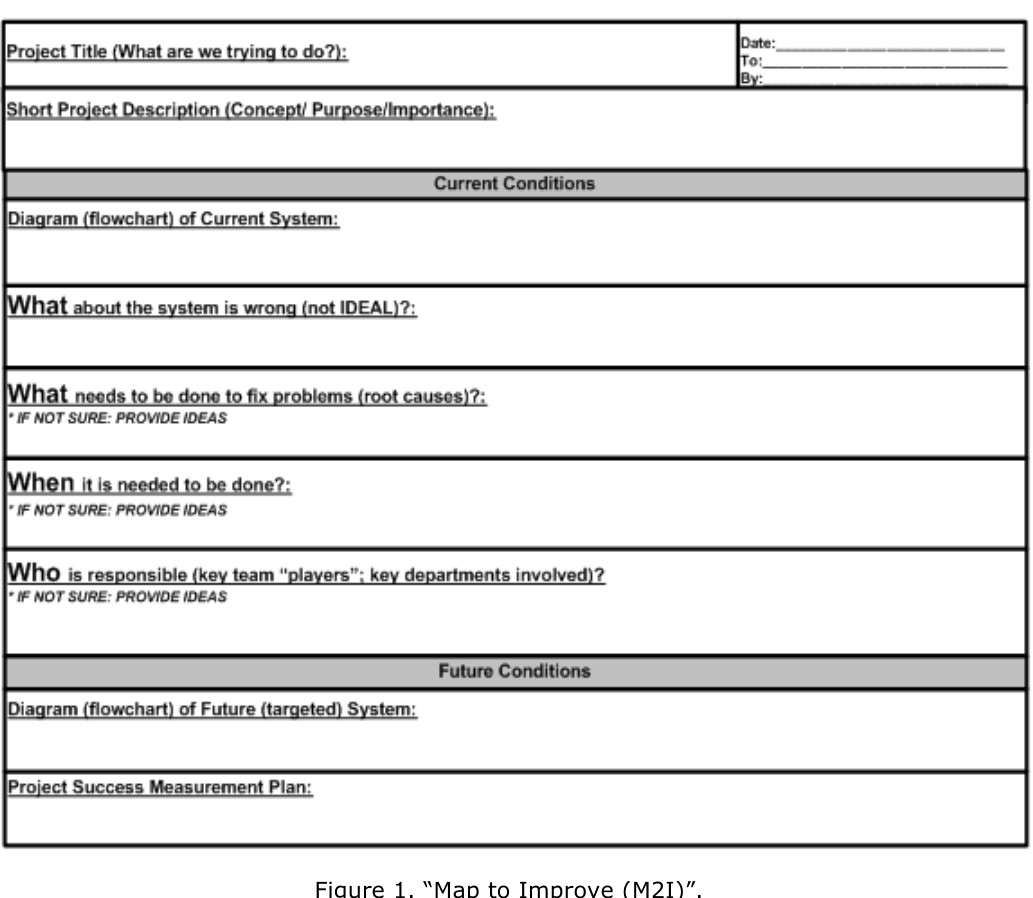
Figure 1. “Map to Improve